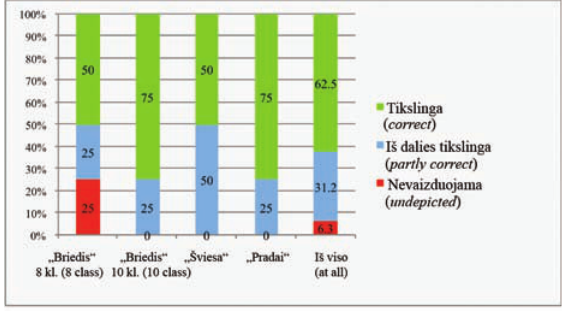
Fig. 5 . Transitive expression in the legends of the analysed economic maps of scholastic geographical atlasess